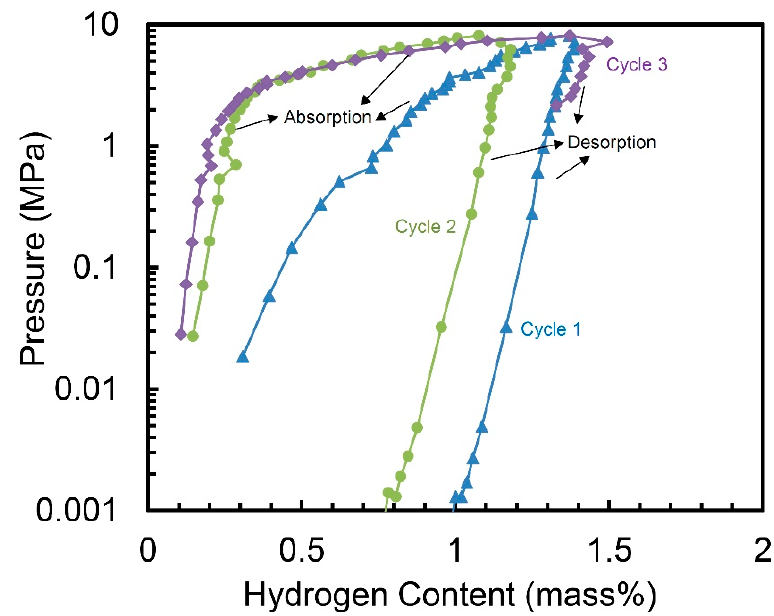
Figure 4. Pressure-composition isotherms (PCT) of the 10 h-milled Ti 50 V 50 -10% C alloy at 30 ◦ C.